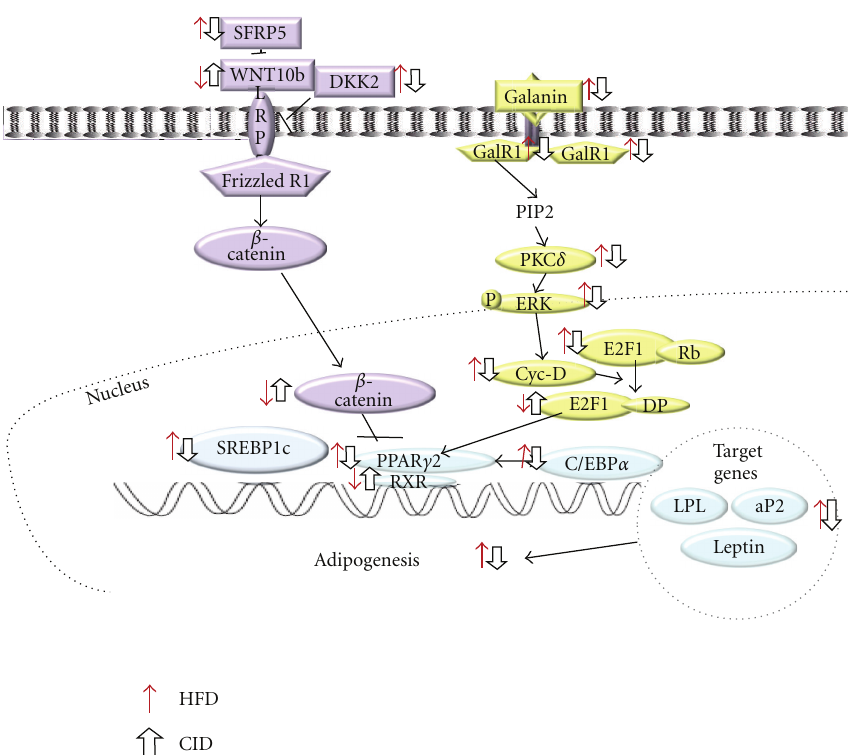
Figure 5: Schematic of the WNT10b and galanin-mediated signaling pathways linked to adipogenesis. In HFD model, increased SFRP5 and DKK2 inhibit WNT10b to combine with LRP and frizzed receptor. Decreased WNT10b signal transduction increases the phosphorylation of β -catenin thus reducing the amount of β -catenin transported to nucleus. In HFD model, decreased amount of β -catenin in nucleus cannot inhibit the activity of PPAR γ resulting in the stimulation of adipogenesis. The HFD also increases gene expression in the galanin- mediated signaling pathway. More galanin binds to its receptors, resulting in increased phosphorylation of ERK, which further induces Cyc-D. Increased Cyc-D promotes more E2F1 to bind to DP that stimulates the expression of PPAR γ 2, C/EBP α , and its target